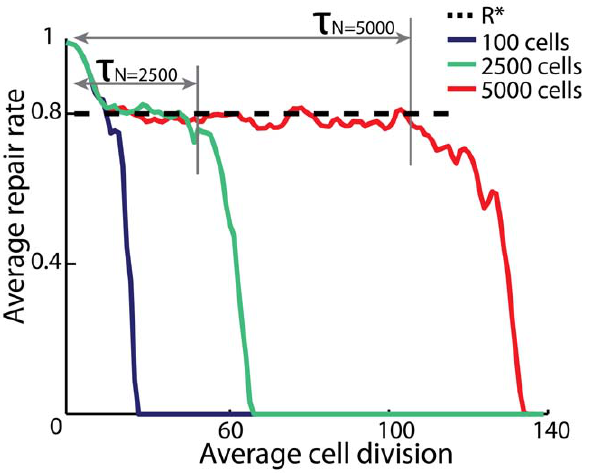
Figure 2. The average repair rate of the system drops as cells irreversibly accumulate mutations. Since cells with a low rate of repair are more likely to go apoptotic, a temporary steady state exists where the repair rate of the system fluctuates around an average value of R (cid:2) : The length of time, t , before the system leaves this temporary state increases drastically with the size N of the system. If t is large, a high rate of repair may be maintained without renewal from the stem cell pool, and consequently the organism ages more slowly. The simulation is carried out with parameters R 0 ~ 0 : 99, a ~ 0 : 05, D ~ 0 : 0056 : The median of 20 simulation runs is